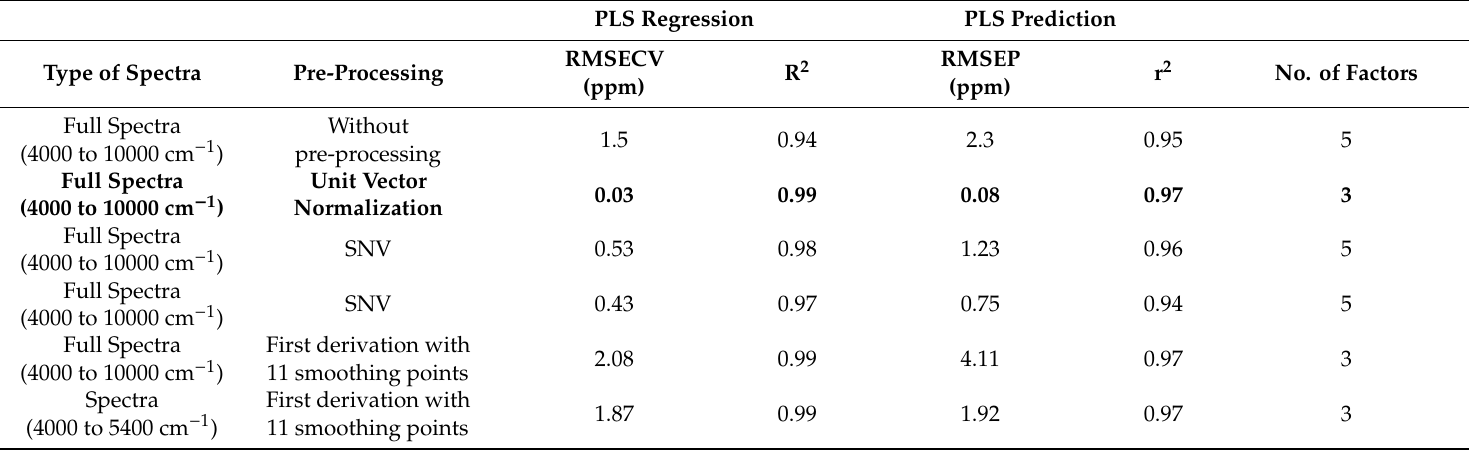
Table 1. Selection of the best spectral pre-processing. PLS: partial least-squares; RMSECV: root mean square error of cross validation; RMSEP: root mean square error of prediction; SNV: standard normal